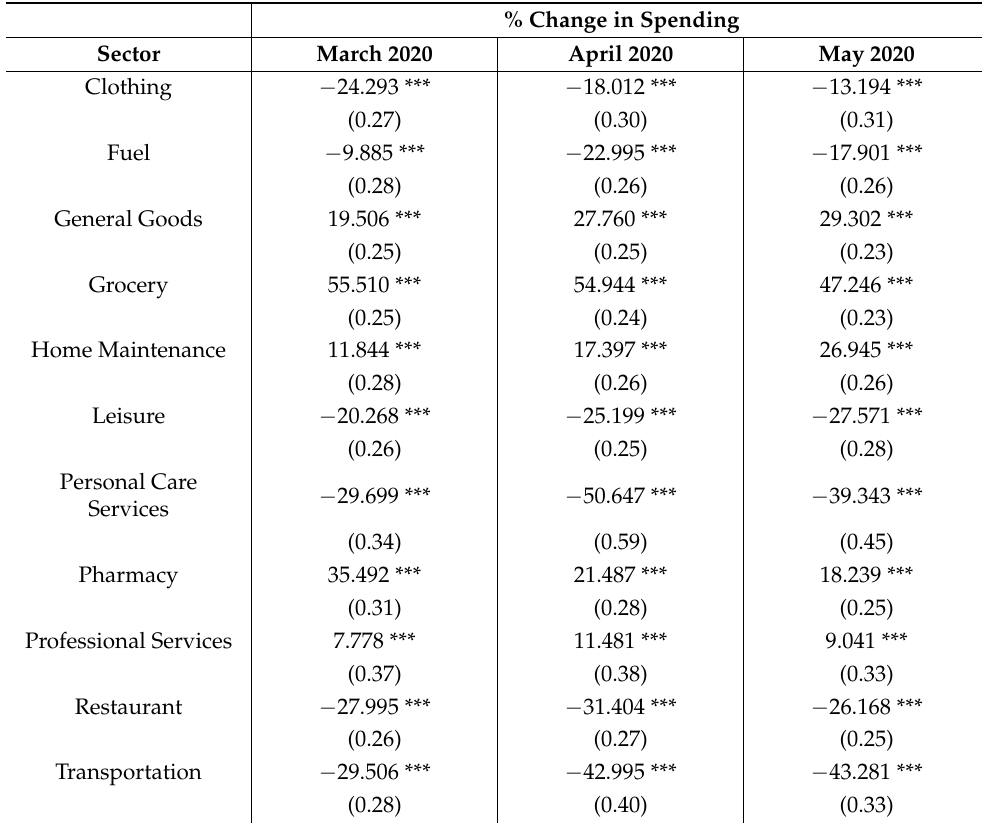
Table 1. Estimated Changes in Spending across Sectors.